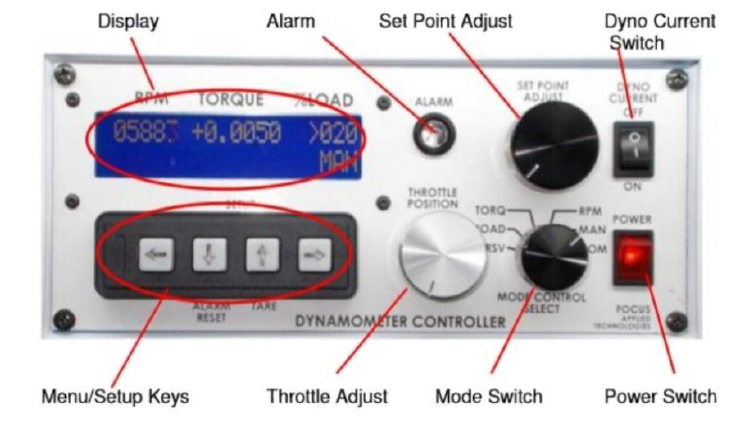
Figure 13. Dynamometer controller system.